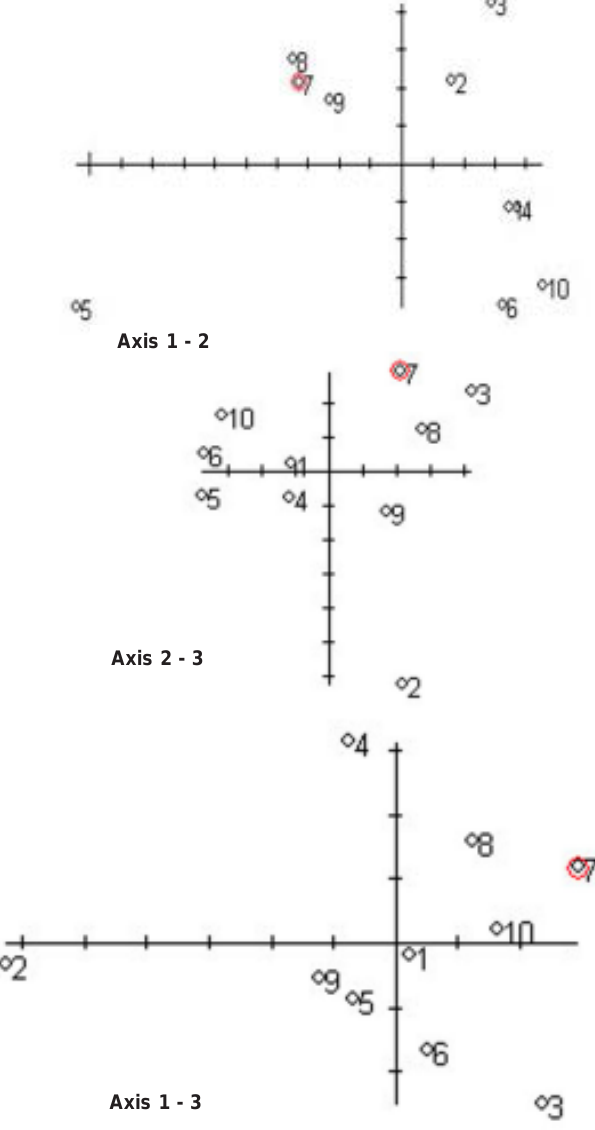
Figure 11. The non – affine deformation for the comparison between Cluex quinquefasciatus male and